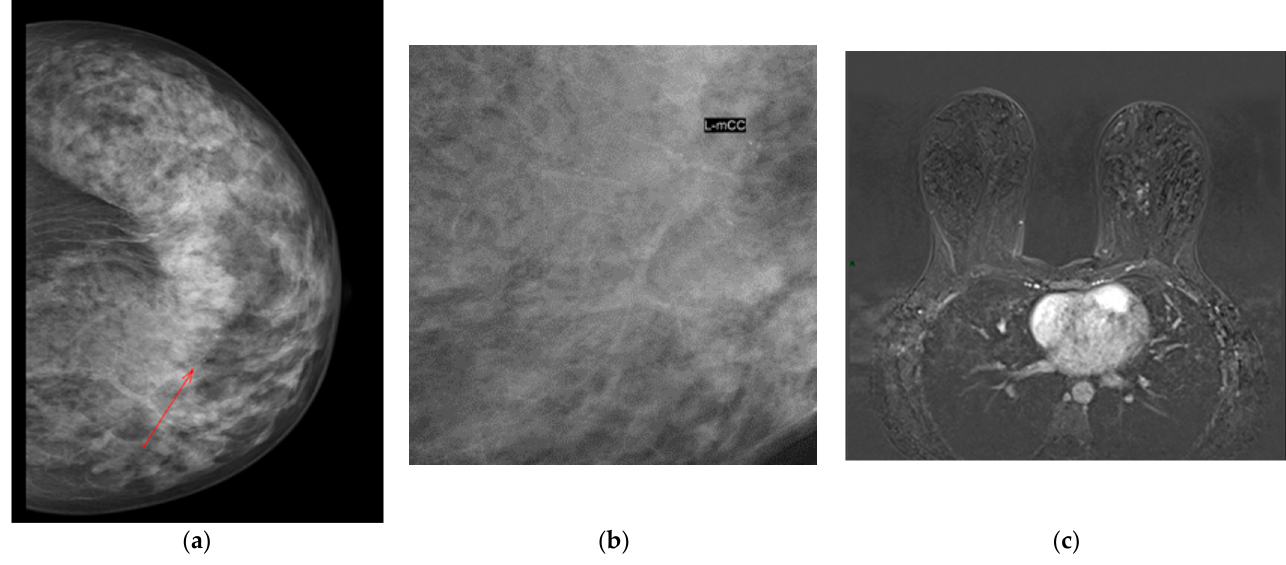
Figure 1. 45-year-old woman with BRCA1 and 2 mutations and mammographic evidence of a clus-